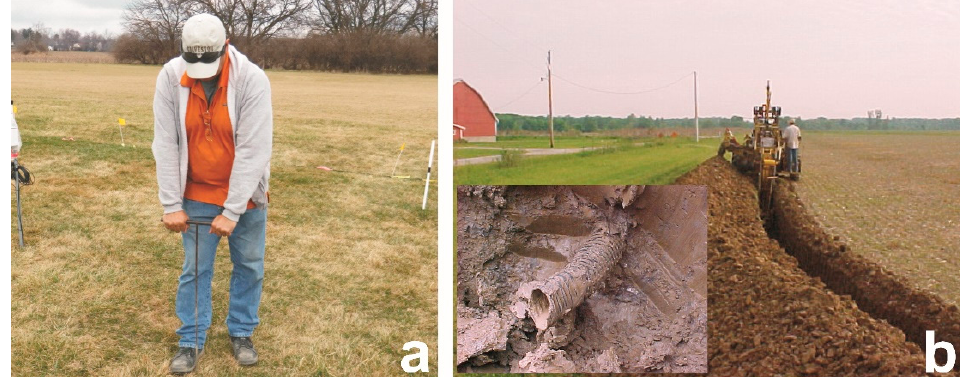
Figure 1. Present methods for finding drainage pipes: ( a ) hand-held tile probe; ( b ) heavy trenching equipment with inset photo showing an example of the drainage pipe damage caused during this excavation operation.